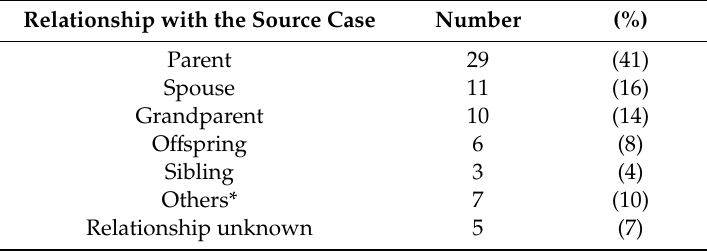
Table 4. The relationship with the source case among the TB patients who had a history of contact, in Udupi district, Karnataka, India during October 2018–June 2019 ( n = 71). Relationship with the Source Case